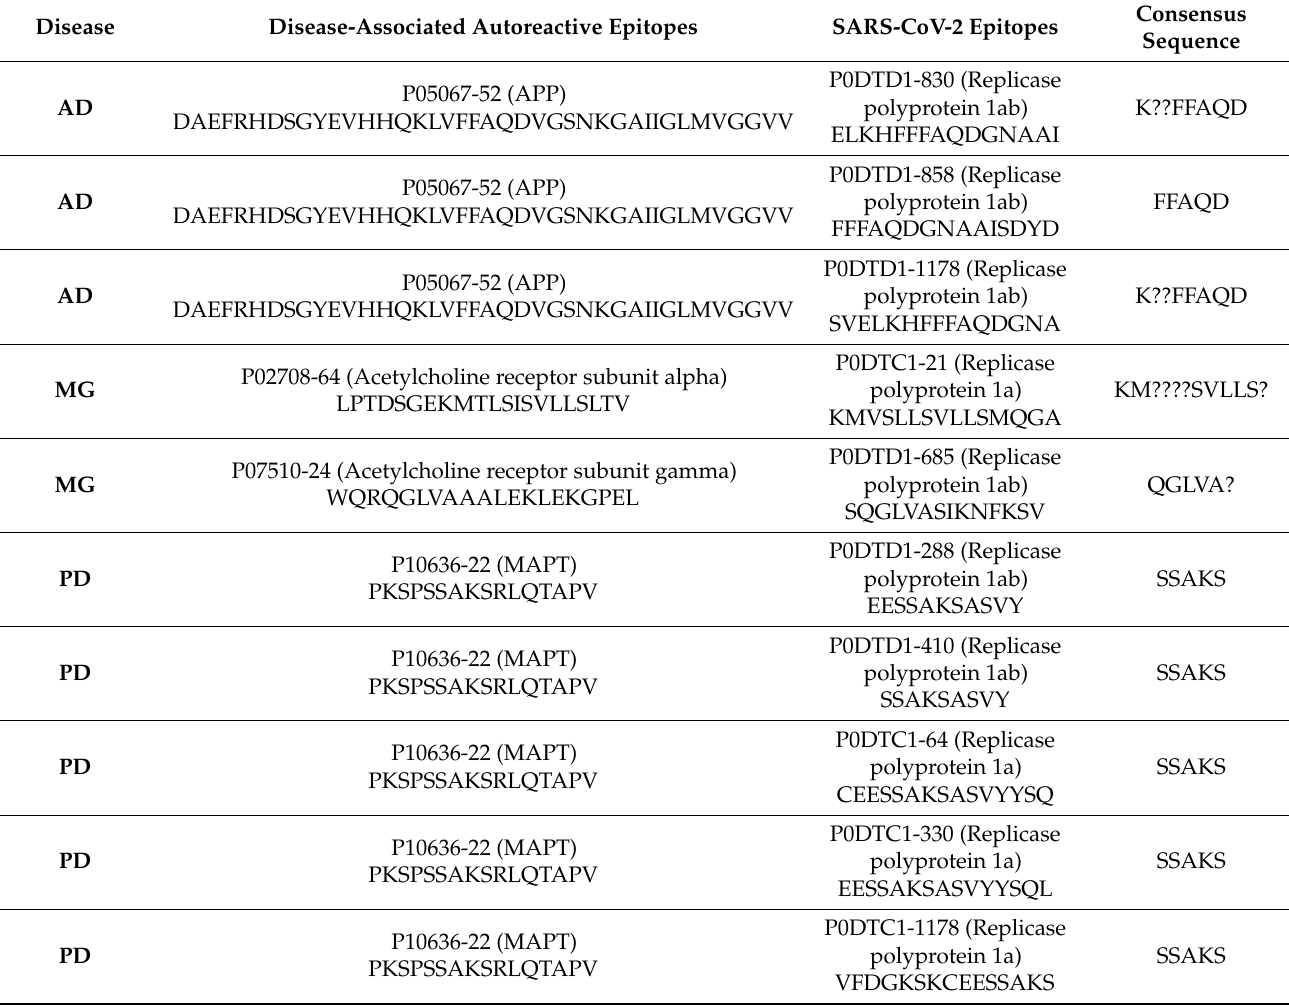
Table 4. Matching 5-mer linear motifs between SARS-CoV-2 epitopes and autoreactive epitopes found in AD, MG and